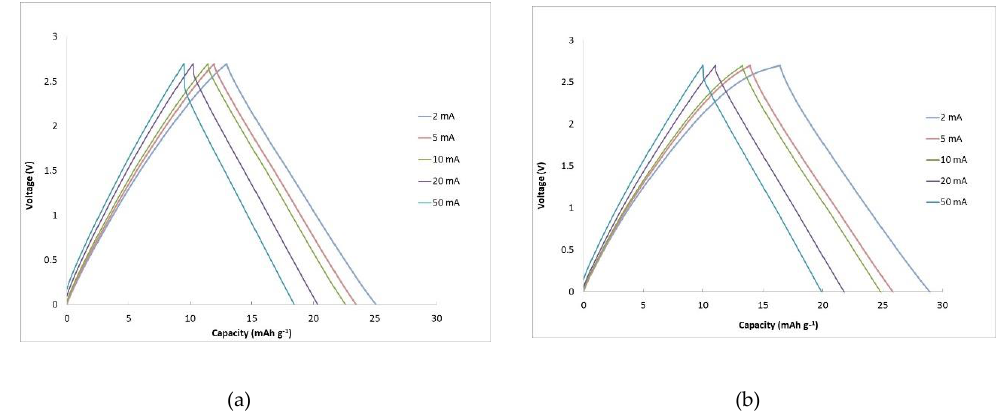
Figure 7. Galvanostatic charge–discharge results for EDLCs with composite electrodes containing ( a ) 0.15 wt% MWCNT; ( b ) 0.15 wt% Ag1-MWCNT–COOH. The capacity values represent charge (mAh) per total mass (g) of the two composite electrodes in the EDLC